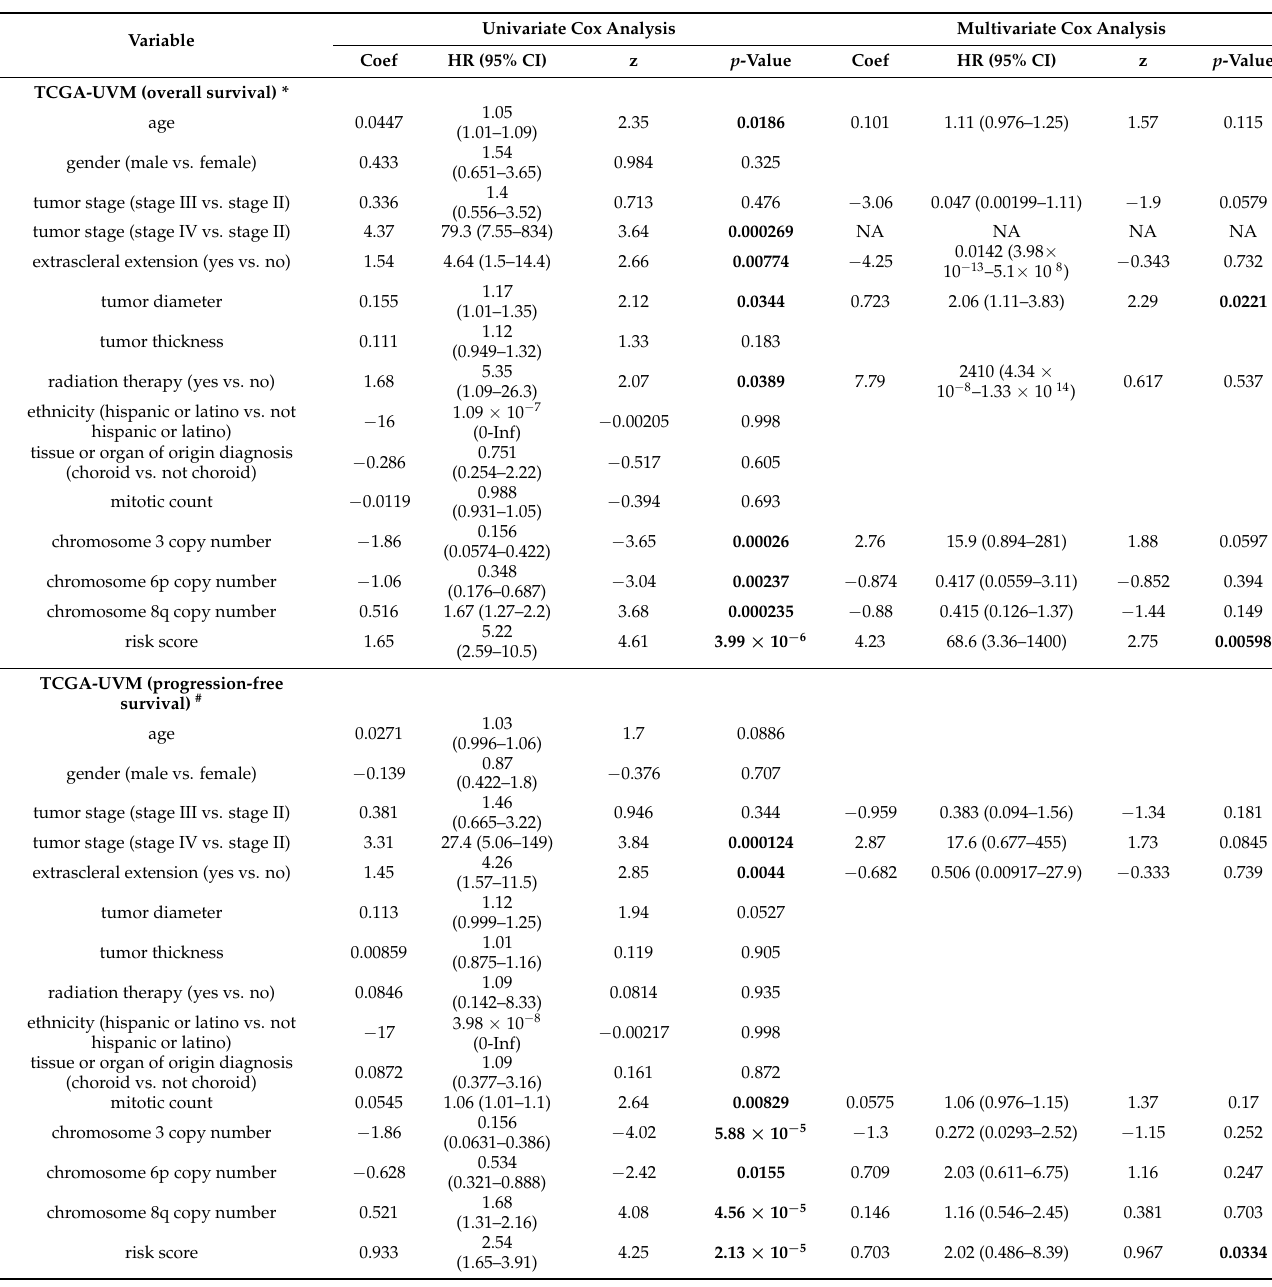
Table 4. Univariate analysis and multivariate analysis of the correlation of gene-signature risk score with outcomes among uveal melanoma patients in two cohorts. Univariate Cox Analysis Multivariate Cox Variable